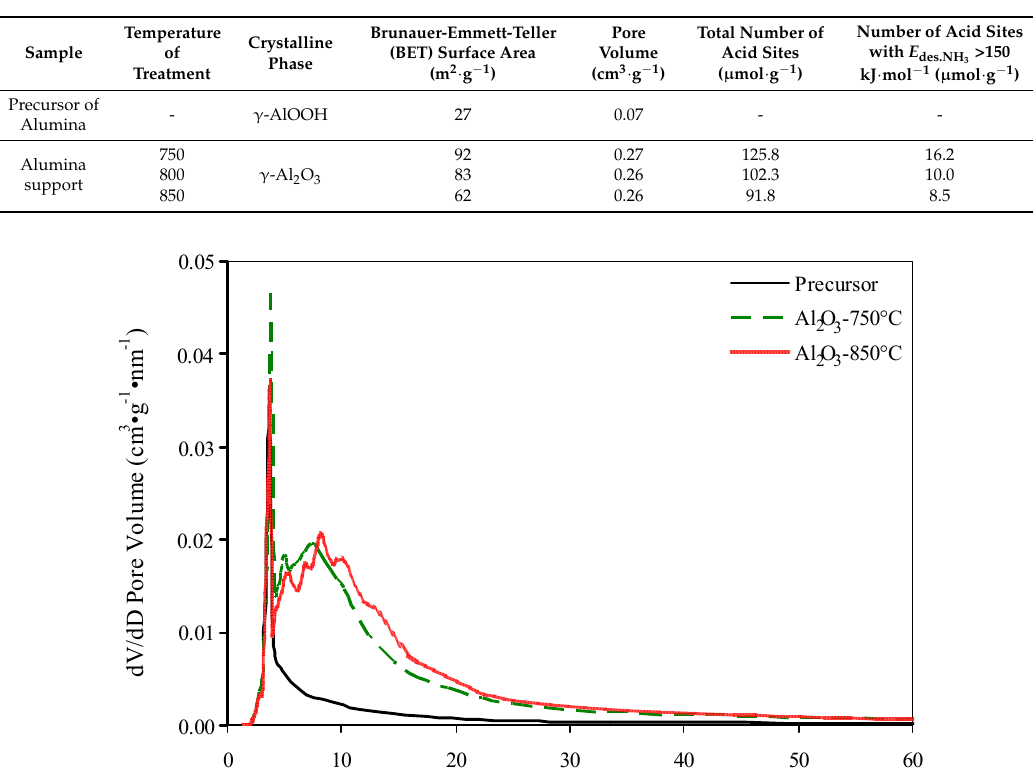
Figure 3. Pore size distribution for precursor of alumina and alumina supports, obtained at 750 °C and 850 °C. Table 1. Integral parameters of the porous system and the acidity of alumina supports.